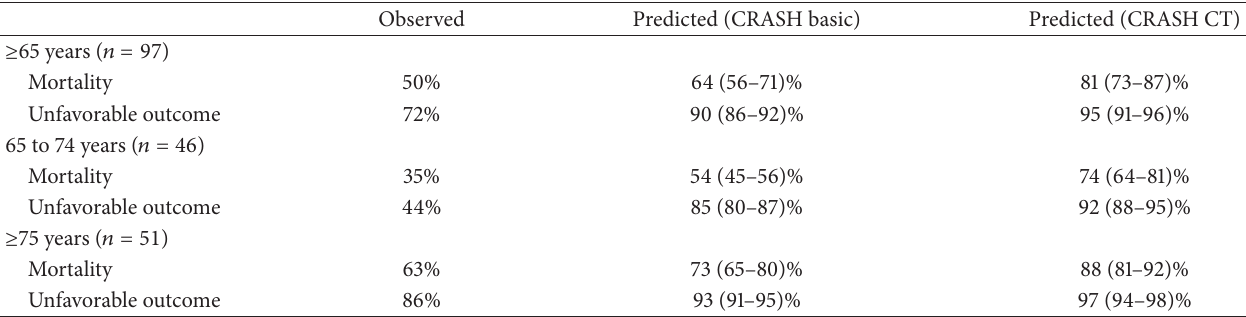
Table 4: Observed 14-day mortality and unfavorable outcome of 12 months and CRASH predicted 14-day mortality and 6-month outcome based on clinical (CRASH basic) and combined clinical and CT based information (CRASH CT). Results are shown for all patients ≥ 65 years, the old group (65–74 years), and the very old group ( ≥ 75